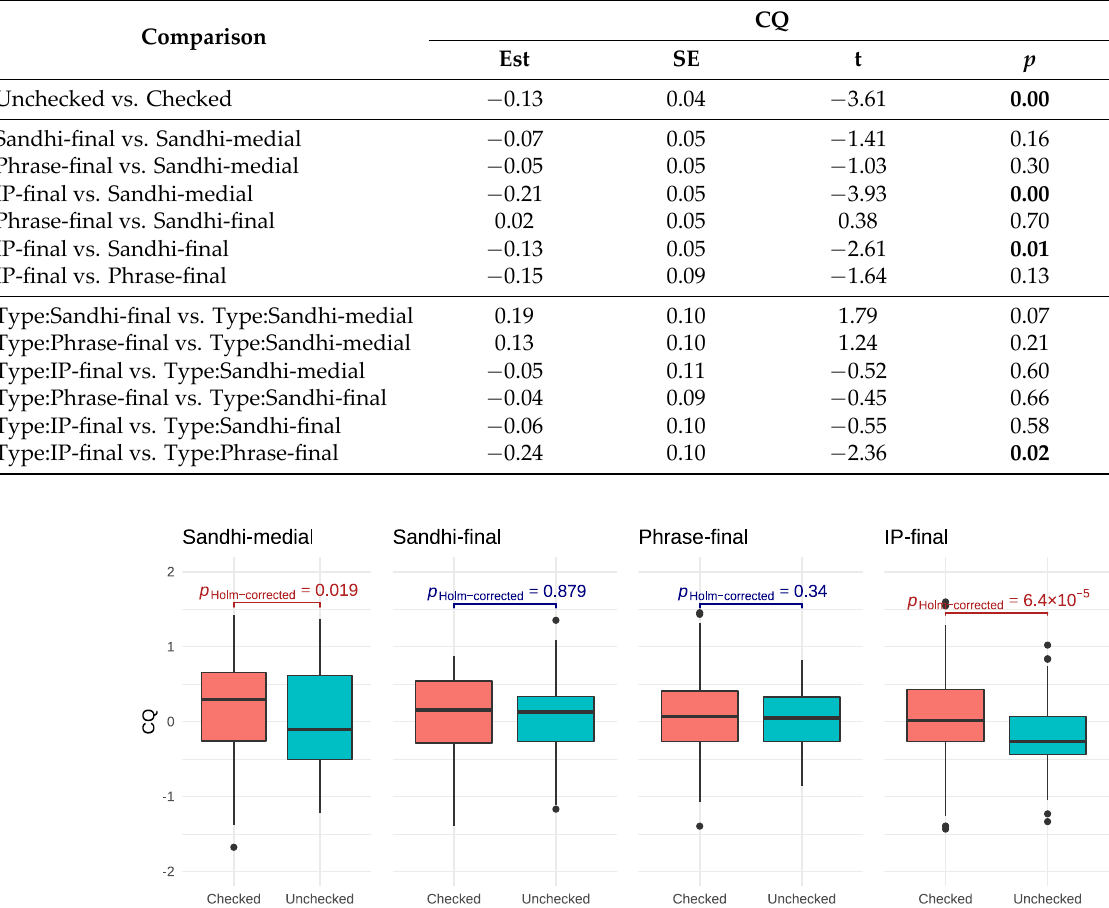
Table 4. Outputs of linear mixed‑effect regression for CQ with interaction effect. Significant p ‑values ( p ⩽ 0.05 ) are marked in bold.